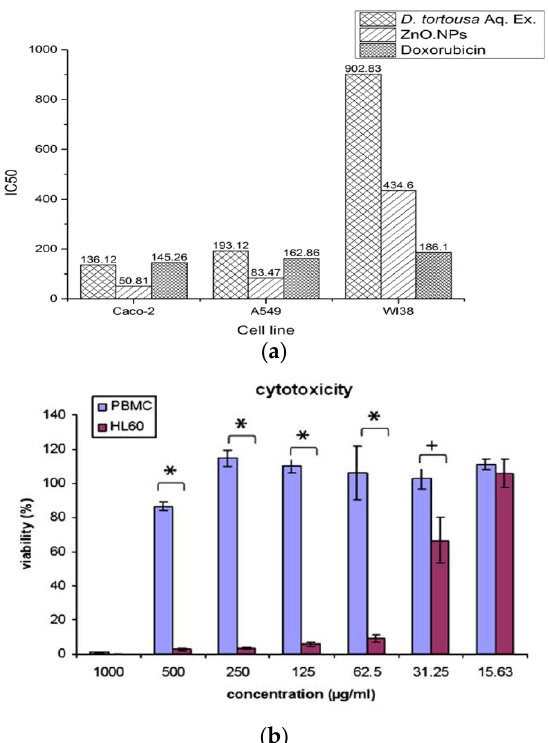
Figure 28. ( a ) The half maximal inhibitory concentration (IC50; µg/mL) for Deverra tortuosa aqueous extract, green ZnO NPs and doxorubicin on Caco-2 and A549 cancer cells as well as WI38 normal cells. IC50: the concentration of tested agent with 50% inhibition of the cell viability. Doxorubicin: chemotherapy drug for treating cancer cells. Reproduced from [159] with permission of Springer Nature under a Creative Commons Attribution 4.0 International License. ( b ) Selective cytotoxic effects of ZnO NPs on HL60 cancer cells and normal PBMCs. The data are expressed as mean ± standard deviation of three identical experiments with three replicates. * p < 0.0001, and + p < 0.05. Reproduced from [160] with permission of Elsevier. Int. J. Mol. Sci. 2020 , 21 , x FOR PEER REVIEW